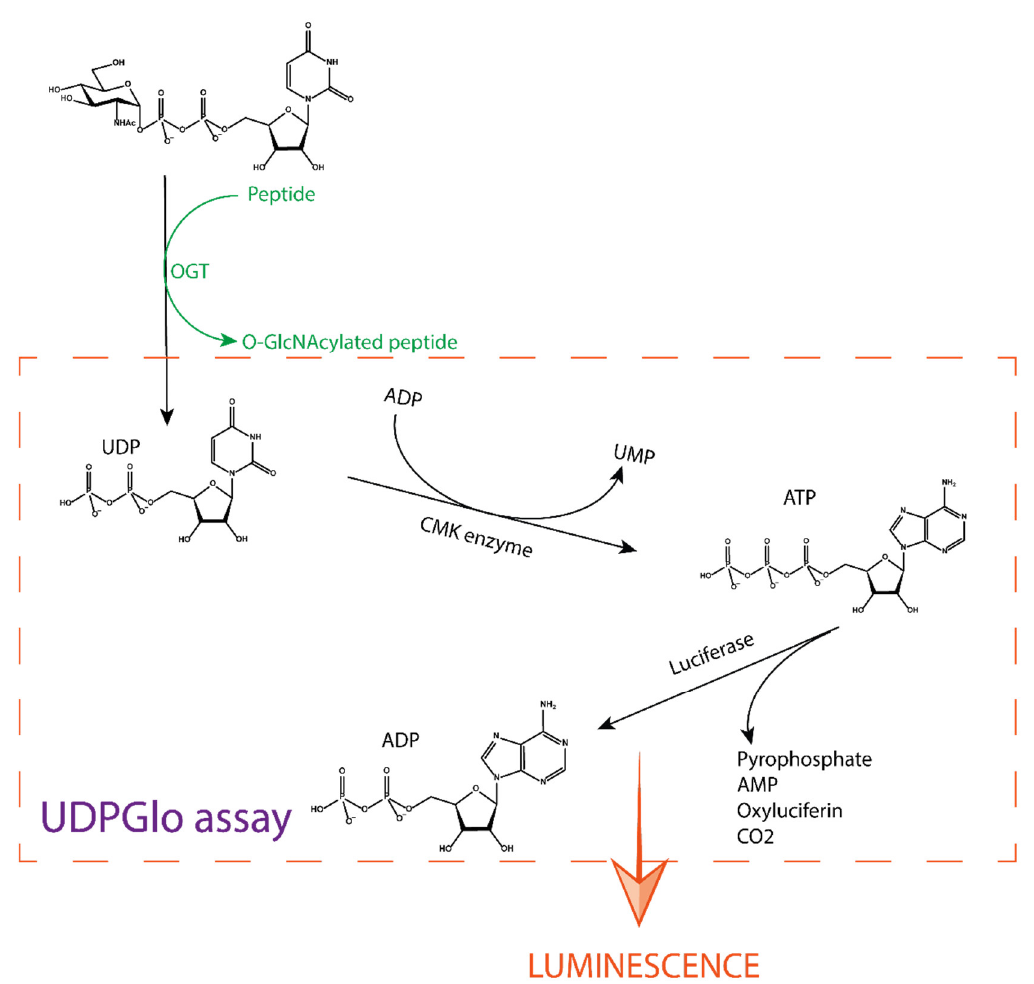
Figure 4. Schematic approach of the UDP-Glo assay. After the production of UDP by the OGT reaction, a specific buffer is added to stop the reaction. This buffer also contains ADP and the cytidine monophosphate kinase (CMK) enzyme that converts UDP to UMP and ADP to ATP. The ATP formed reacts with oxyluciferin in a luciferase-catalysed reaction. This reaction yields carbon dioxide, AMP, pyrophosphate, and luminescence. The amount of light produced is directly proportional to the concentration of UDP formed in the OGT reaction.